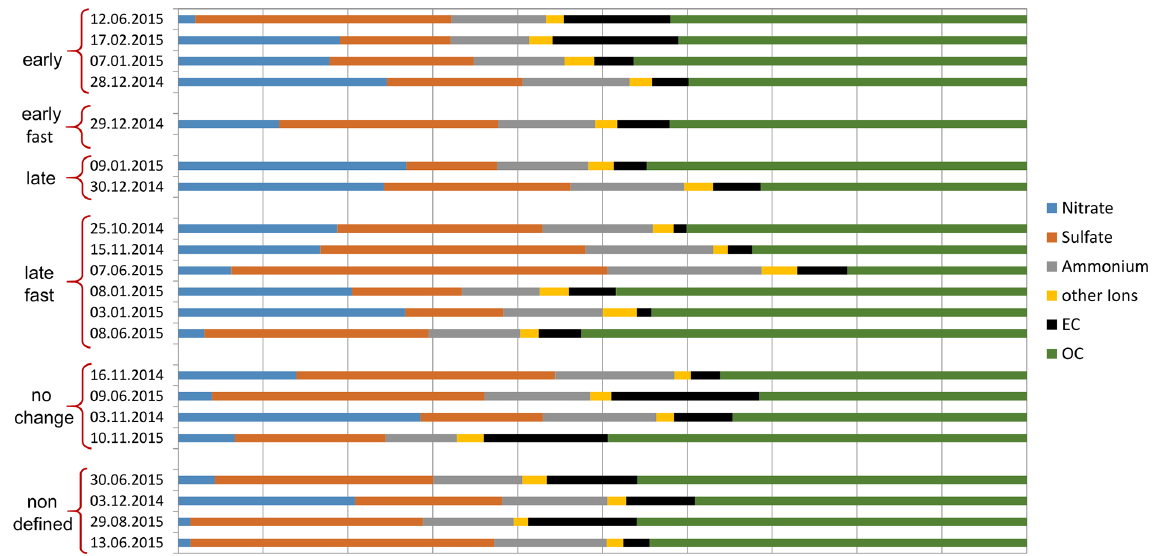
Figure 7. Fractions of analyzed ions, elemental carbon (EC) and organic carbon (OC) sorted by the categories representing the behavior of the Raman spectra during the thermal–optical heating procedure. The contribution of minor ions to the category “other ions” can be found in the Supplement.